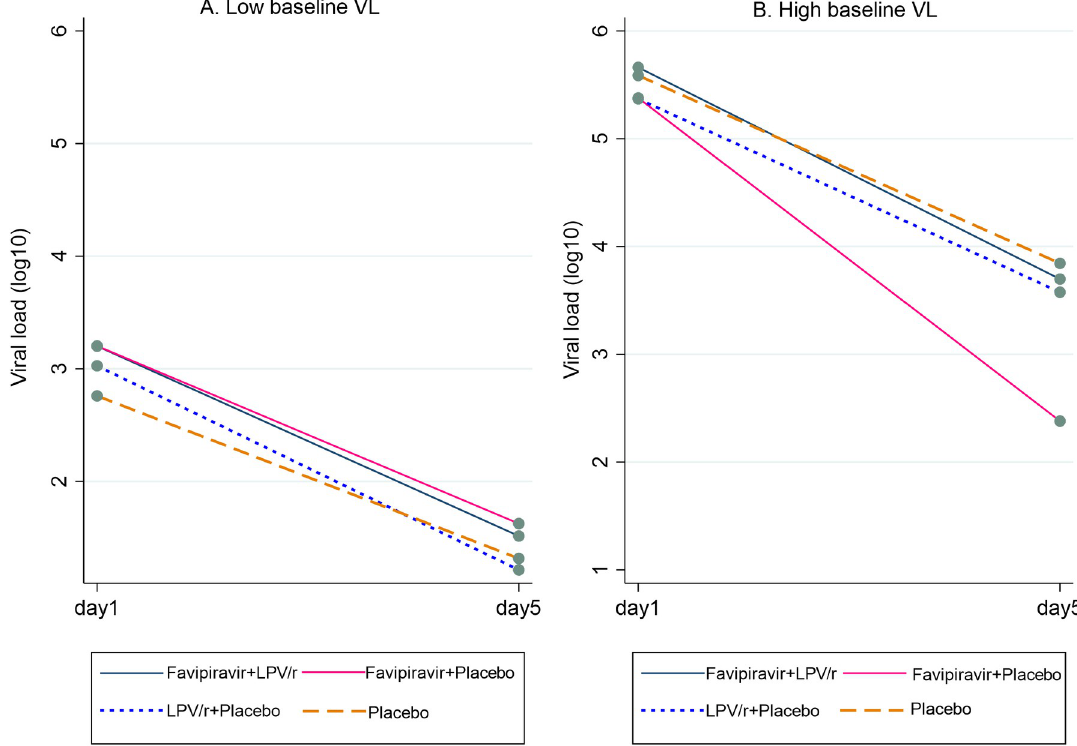
Fig 3. Mean log 10 SARS-CoV-2 viral load at baseline (Day 1) and Day 5 per treatment arm in (A) participants with baseline viral load below or equal to the median level for the entire cohort and (B) participants with baseline viral load above the median level for the entire cohort. LPV/r, lopinavir-ritonavir; SARS-CoV-2, Severe Acute Respiratory Syndrome Coronavirus 2; VL, viral